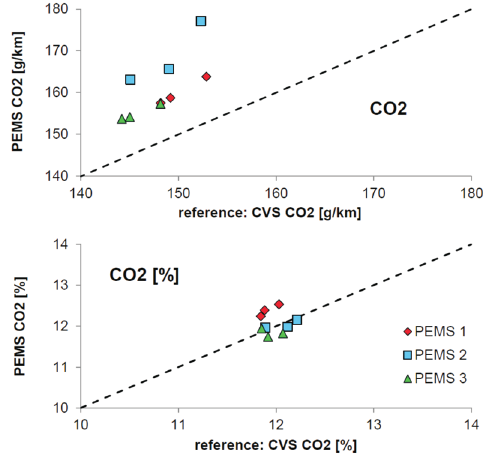
Fig. 6. Correlations of emissions measured with PEMS and with station - ary CVS-installation in NEDC